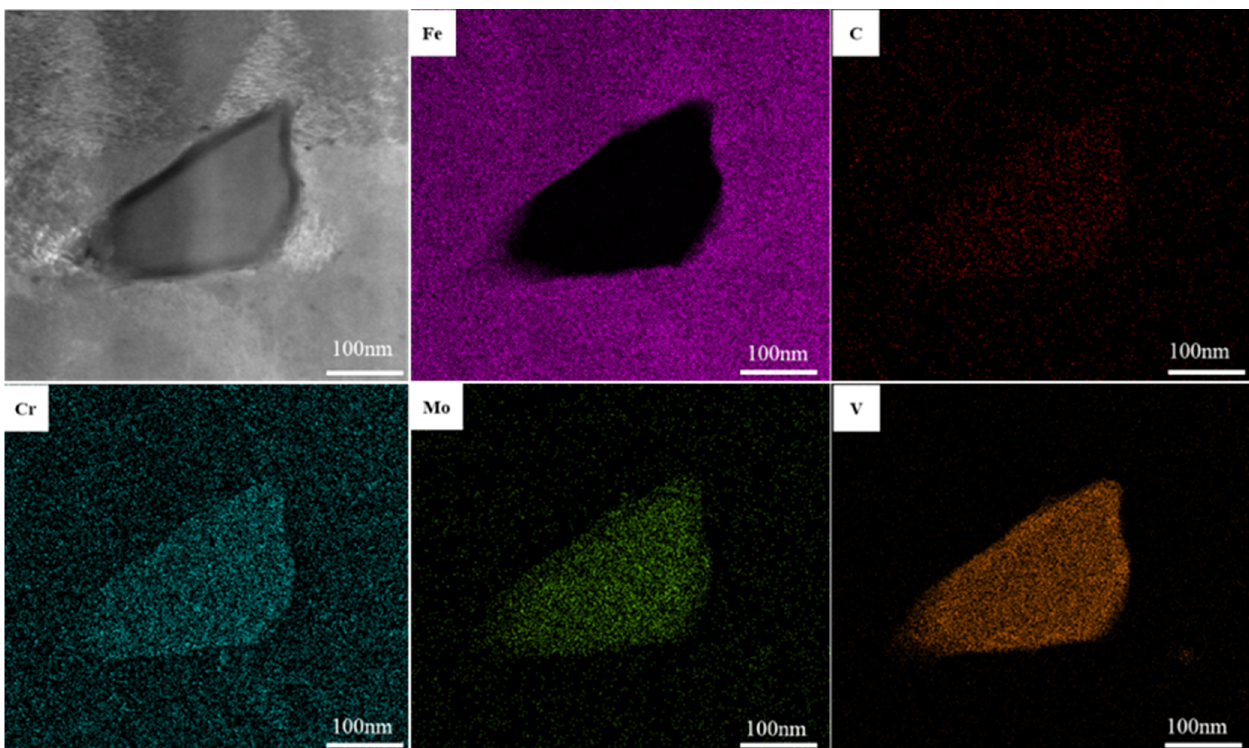
Figure 4. TEM image of carbide and corresponding EDS maps.